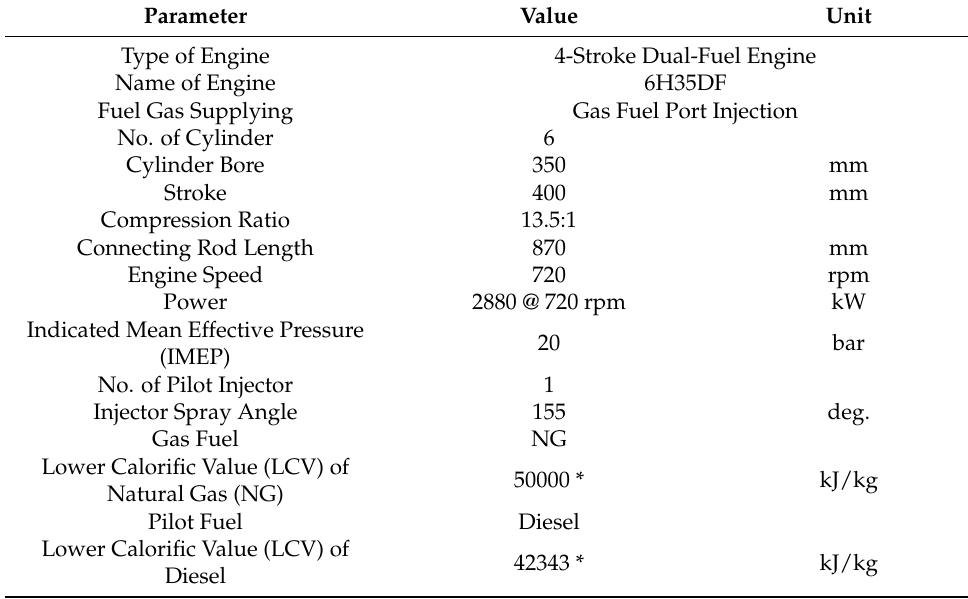
Table 1. The specifications of the simulated